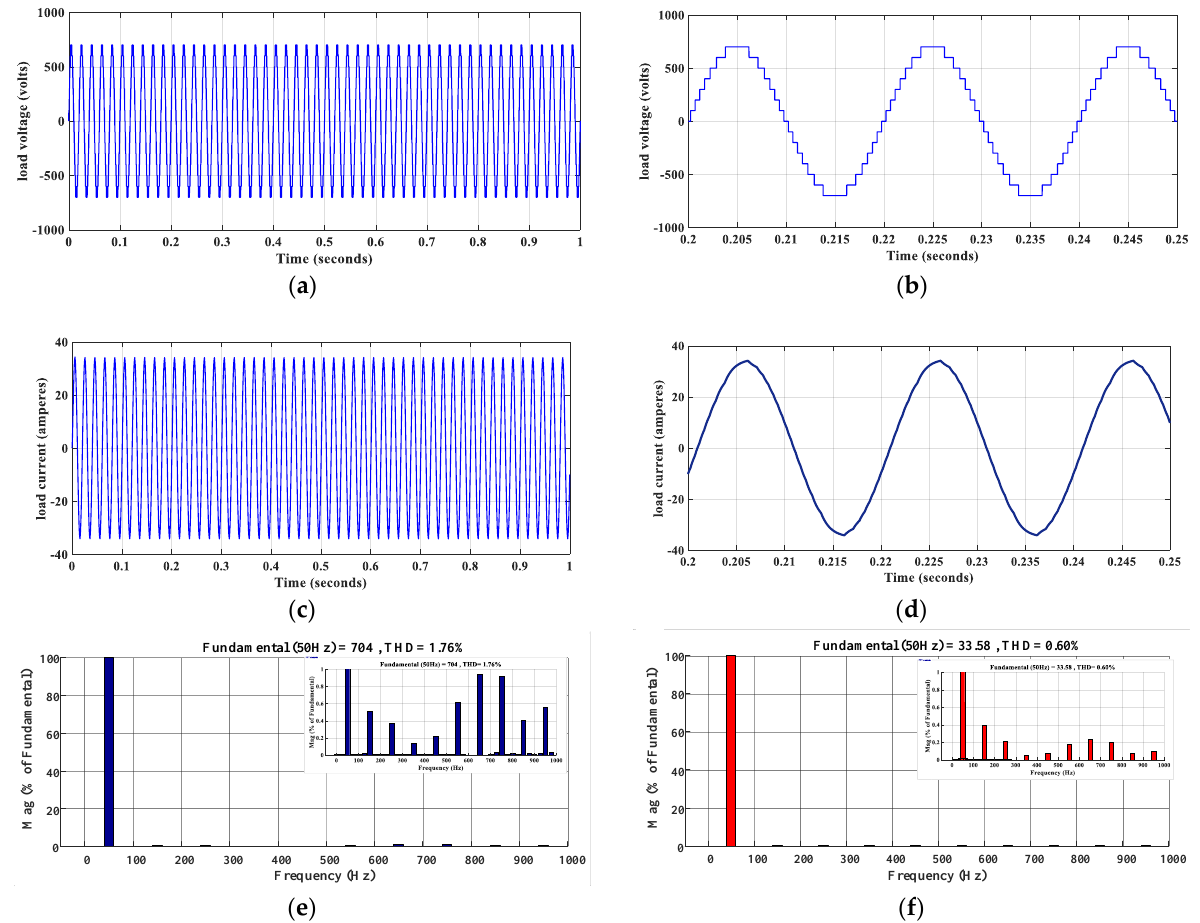
Figure 4. Simulation results of the proposed structure during healthy operation comprising ( a ) load voltage, ( b ) magnified view of load voltage, ( c ) load current, ( d ) magnified view of load current, ( e ) voltage harmonic characteristics acquired from Fourier analysis, and ( f ) current harmonic characteristics.